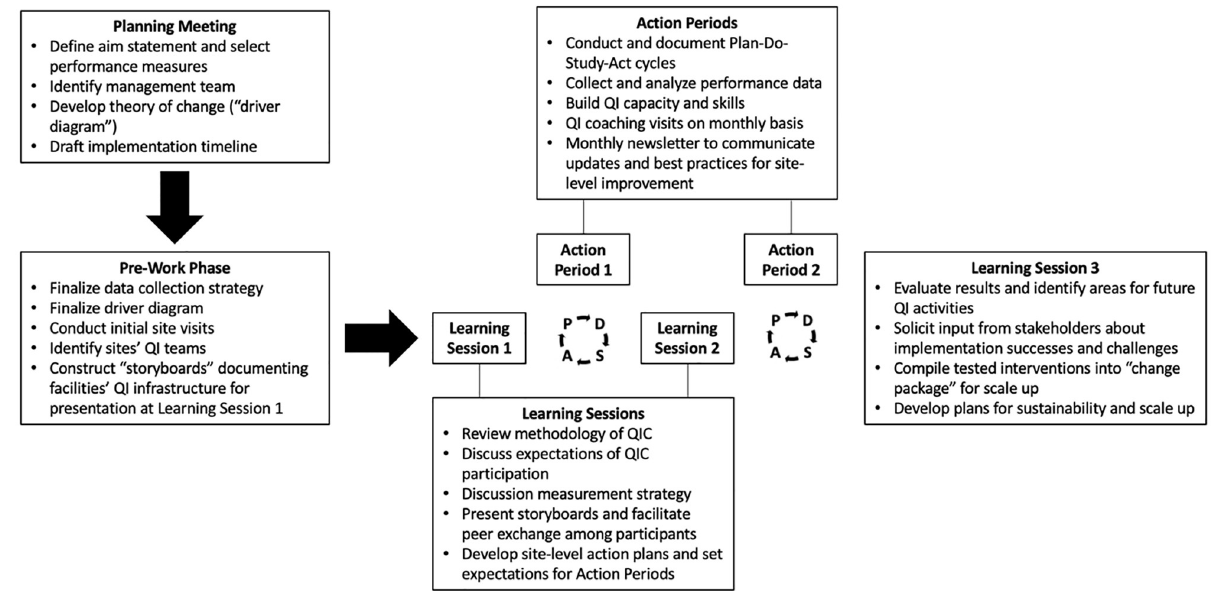
Fig 1. NAMPROPA structure and activities. QI–quality improvement; QIC–quality improvement